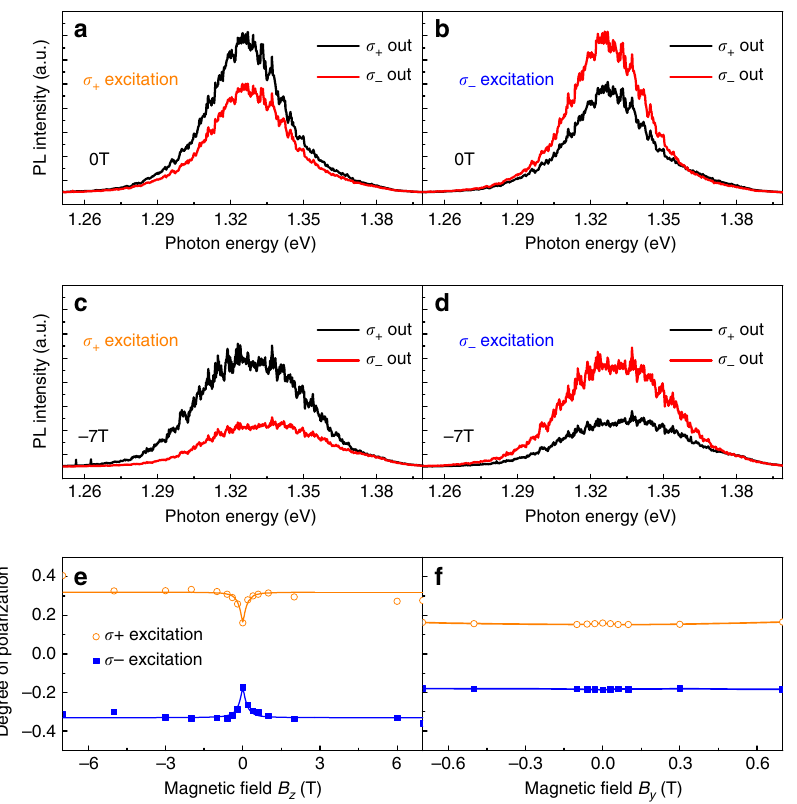
Fig. 2 Valley polarization with CW laser excitation. a , b Valley polarization at 0 T. Right and left circularly polarized light are labeled as σ + and σ − . Under σ + laser excitation, σ + PL output component is more than σ − and vice versa for σ − excitation. This shows evidence of valley polarization. c , d Valley polarization at − 7 T. Valley polarization is enhanced by applying magnetic fi eld perpendicular to the sample surface. e The valley polarization degree as a function of applied magnetic fi eld in the z direction. The solid line is the fi tting result following equation P j ¼ P j excitation polarization, P j is the residual degree of polarization at 0 T due to the valley polarization, P j 0 represents the intervalley scattering between the dark exciton. f , The valley polarization degree as a function of applied magnetic fi eld in the y direction with B = z